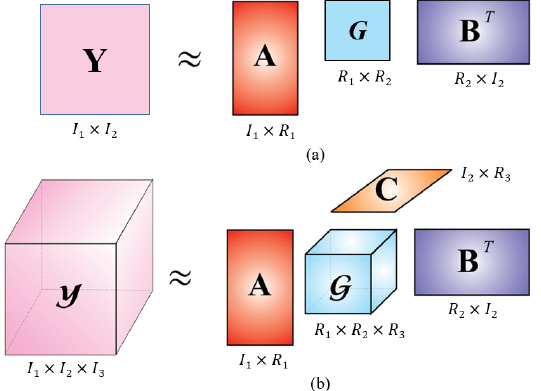
Figure 4. Matrix decomposition vs. tensor decomposition: ( a ) low-rank matrix decomposition (truncated SVD); ( b ) low-rank tensor decomposition (Tucker